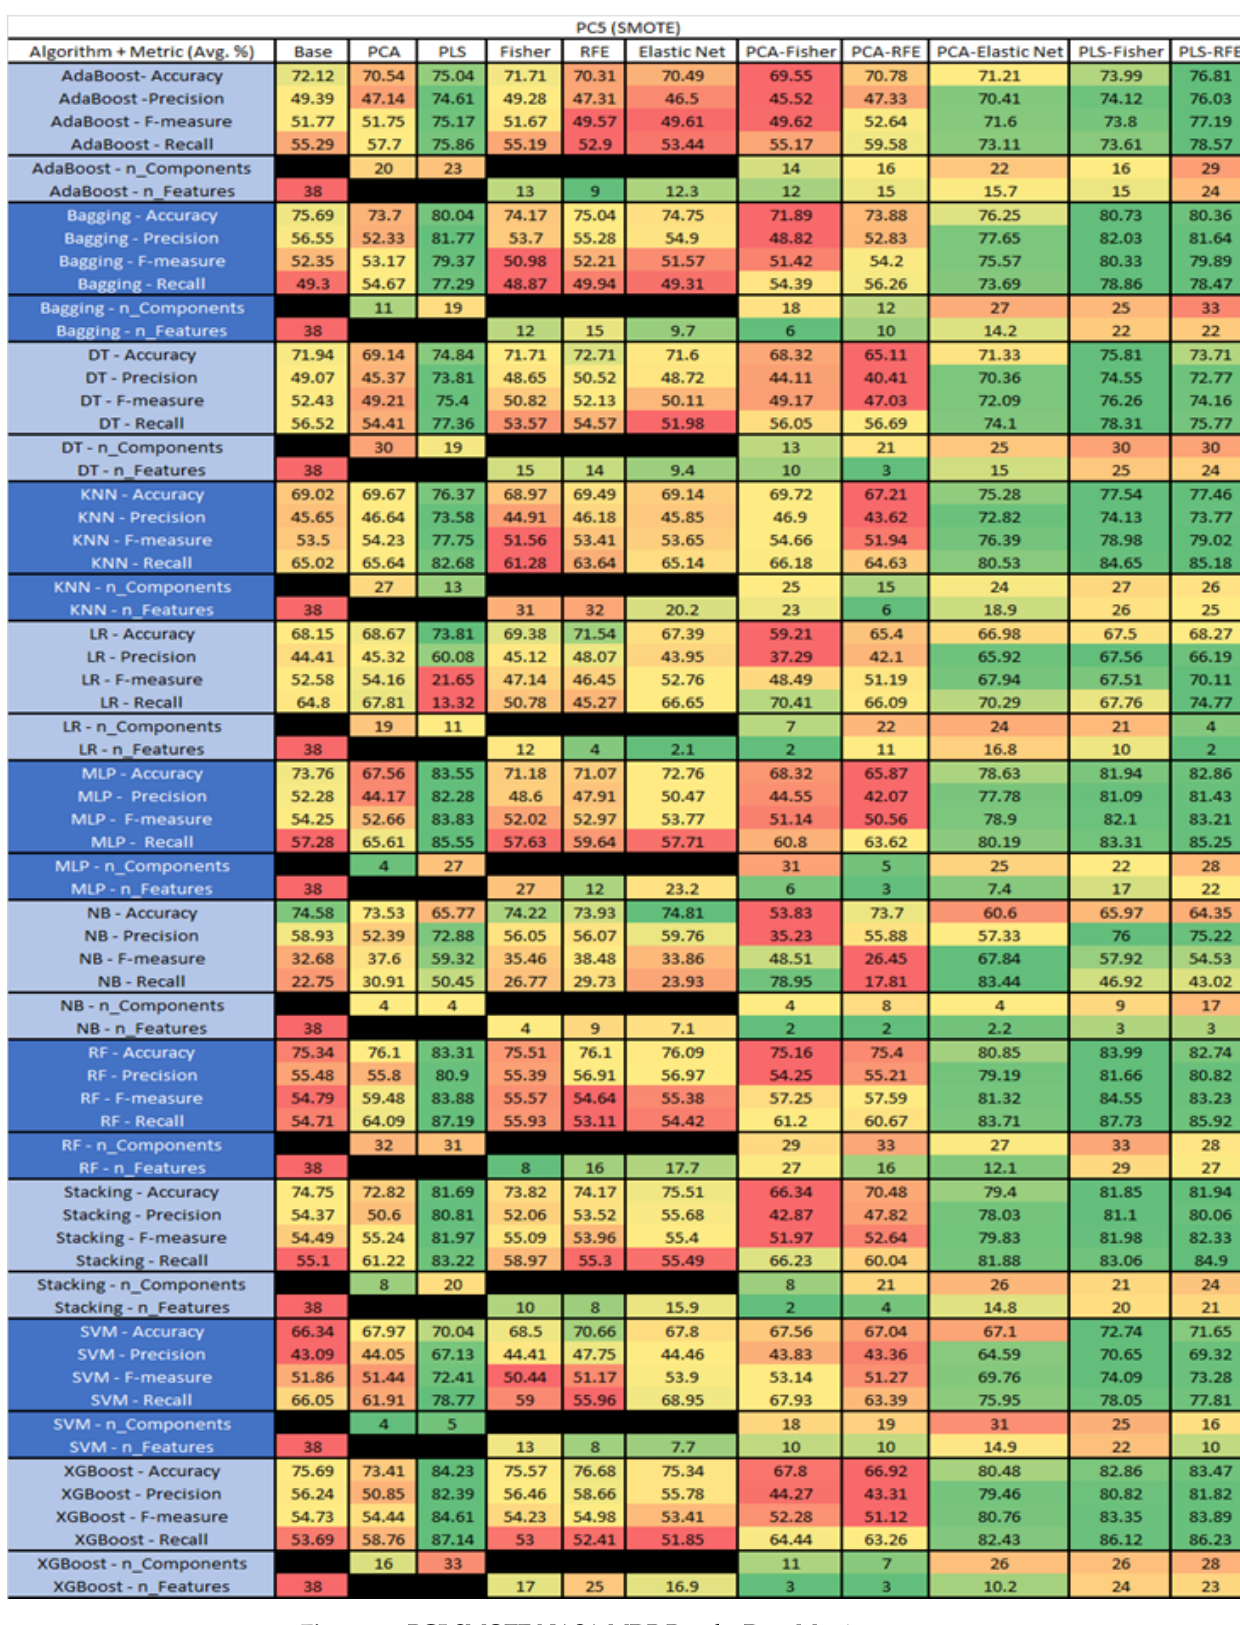
Figure 49. PC5 SMOTE NASA MDP Results Data